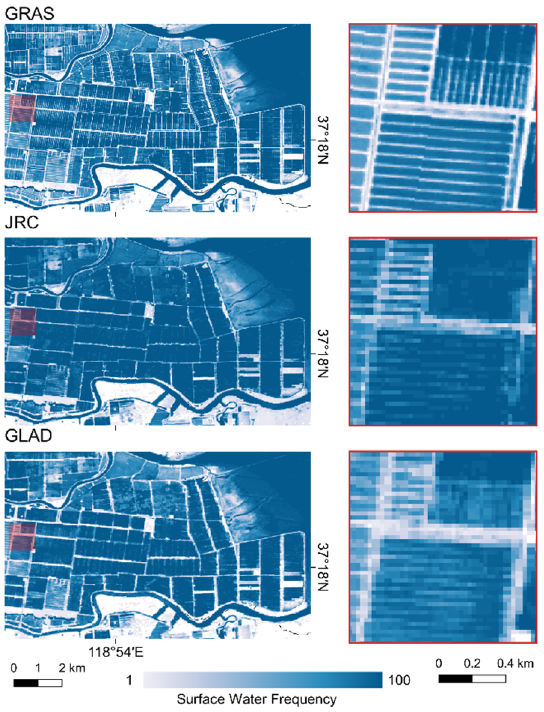
Figure 8. Surface water frequency over aquaculture site located near Haizhou Bay on the east coast of China.